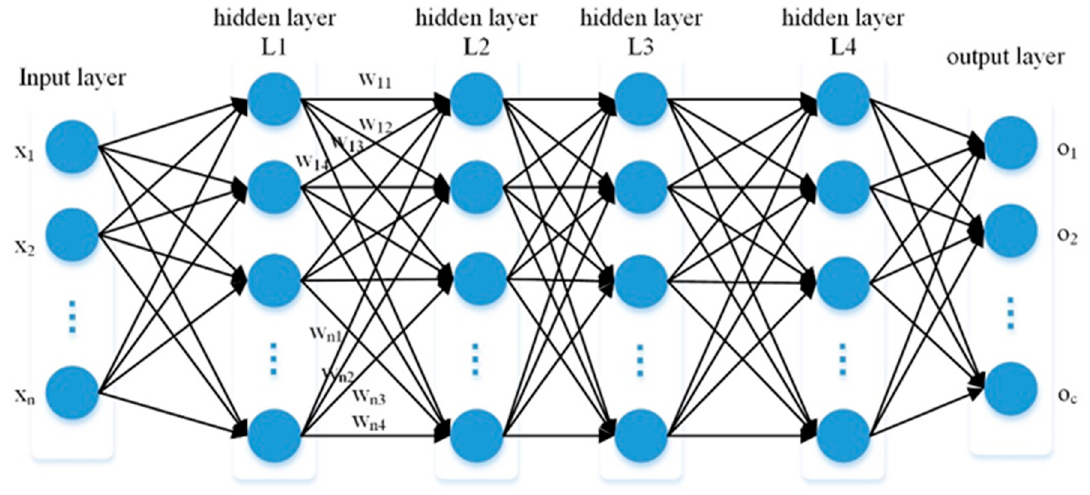
Figure 1. Structure diagram of DNN.